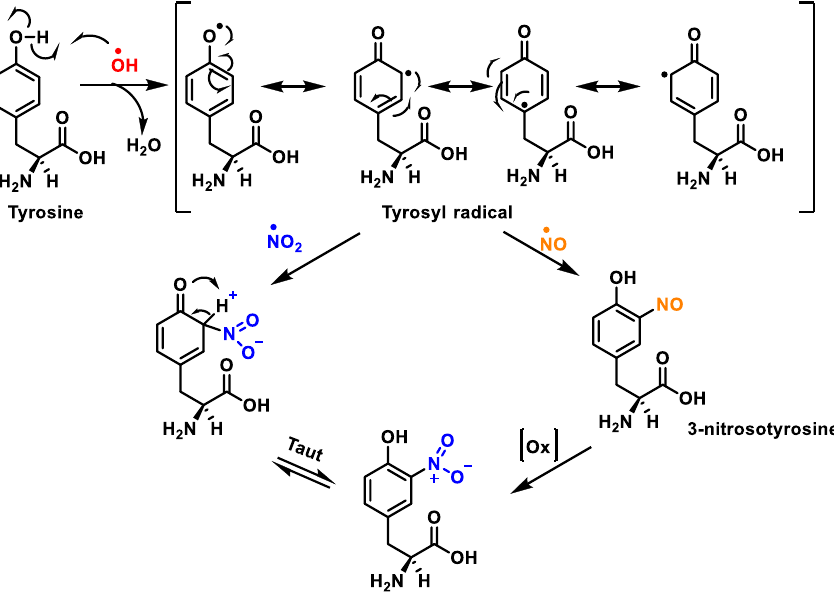
Figure 8. Tyrosine nitration with • NO 2 and nitrosation with • NO to nitrotyrosine.